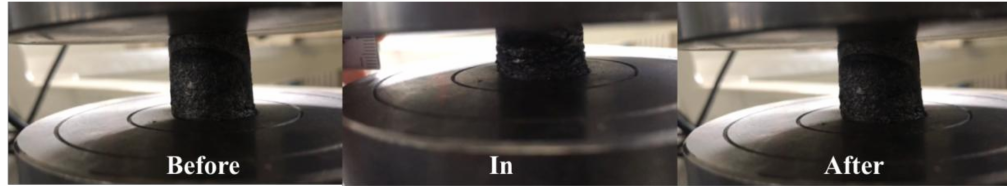
Figure 6. Macrostructure of before, in and after